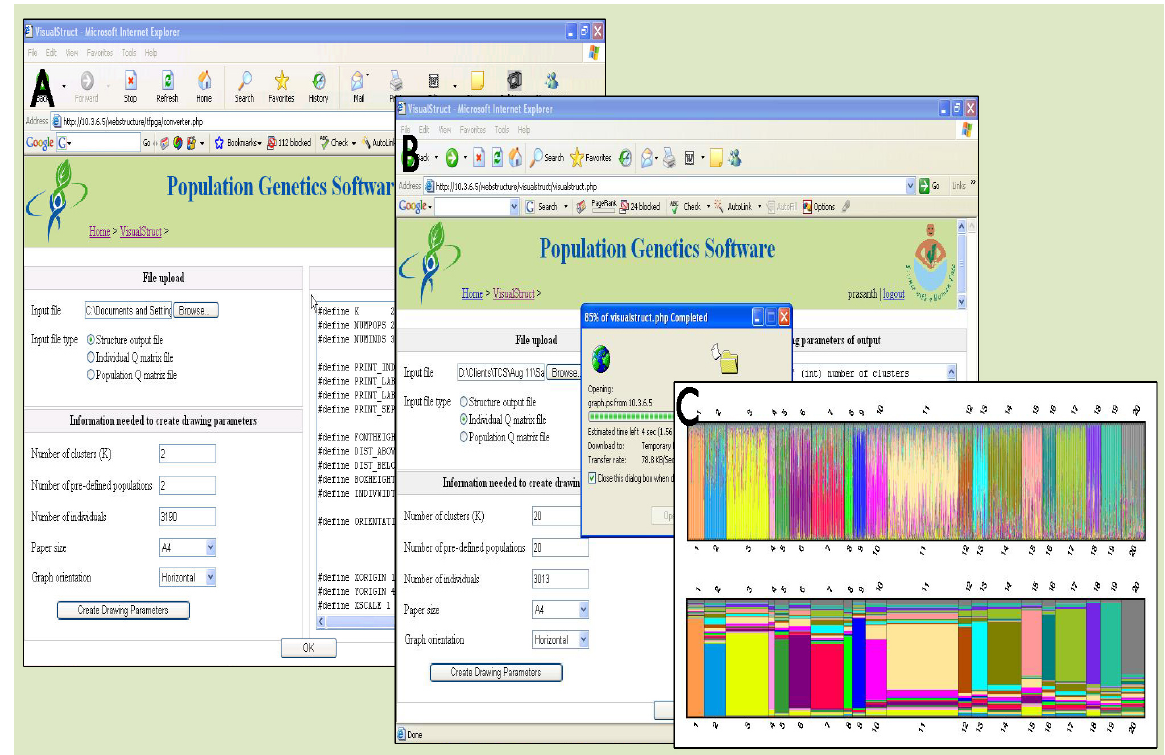
Figure 2: VisualStruct interfaces (A&B) providing input file information and setting drawing parameters, (C) a typical output